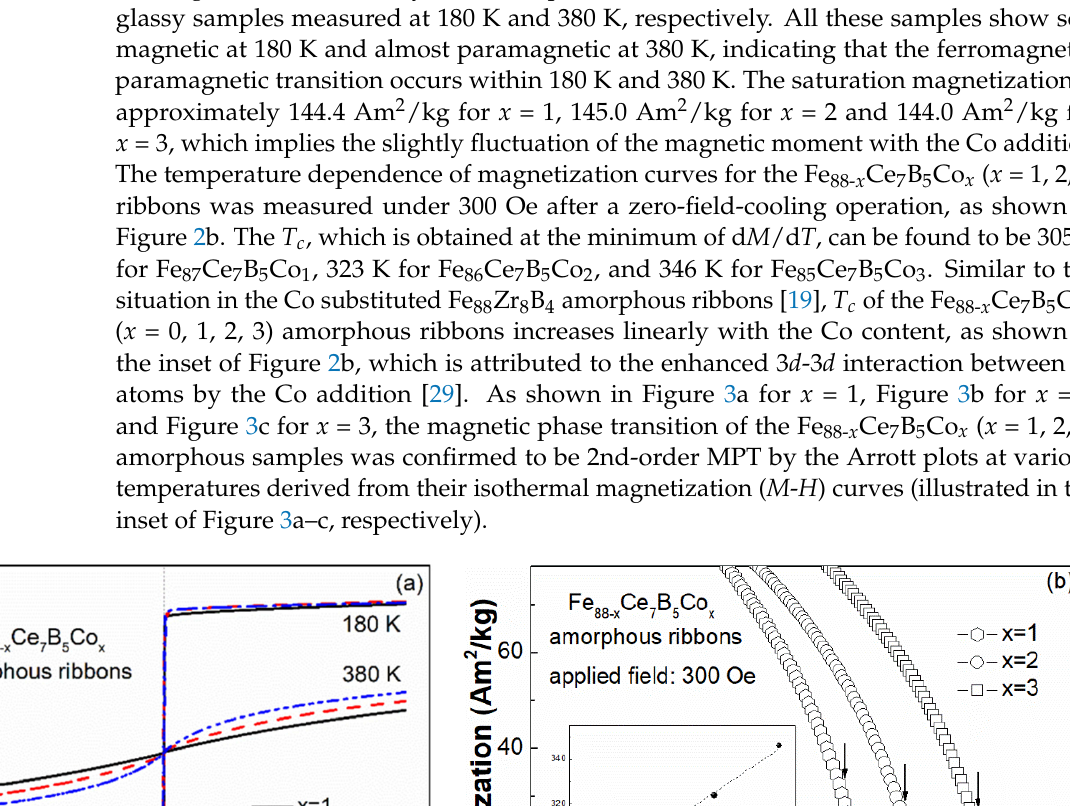
Table 1. The thermal properties of the Fe 88- x Ce 7 B 5 Co x ( x = 0, 1, 2, 3) amorphous ribbons.